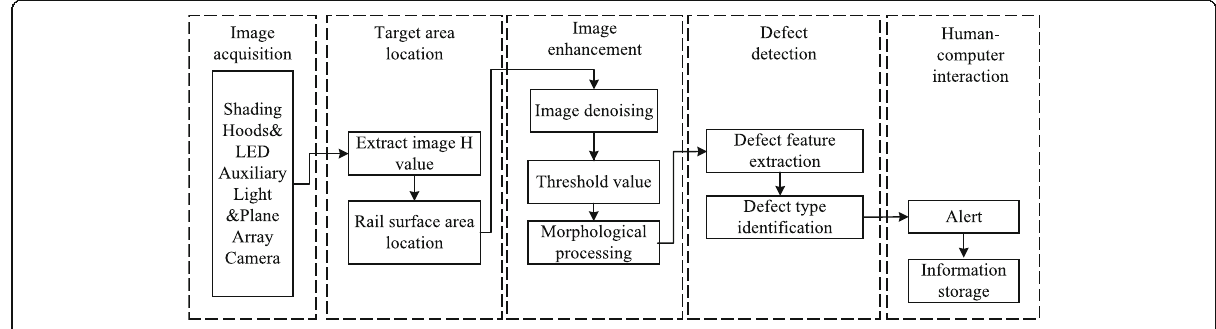
Fig. 1 Schematic diagram of detection system